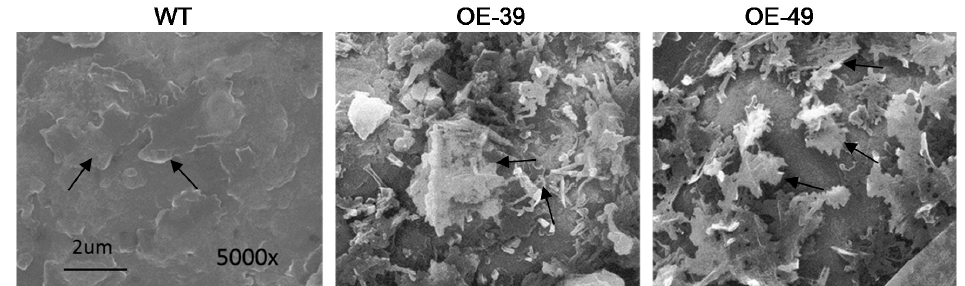
Figure 4. Overexpression of BnWIN1 enhanced epicuticular wax crystals accumulation under salt stress. Epicuticular wax crystals of leaf surface were observed under scanning electron microscopy. Forty-day-old plants grown in soil in pots were treated with 200 mM NaCl for 30 days and leaf samples were taken for observation. Arrows indicate wax crystals.